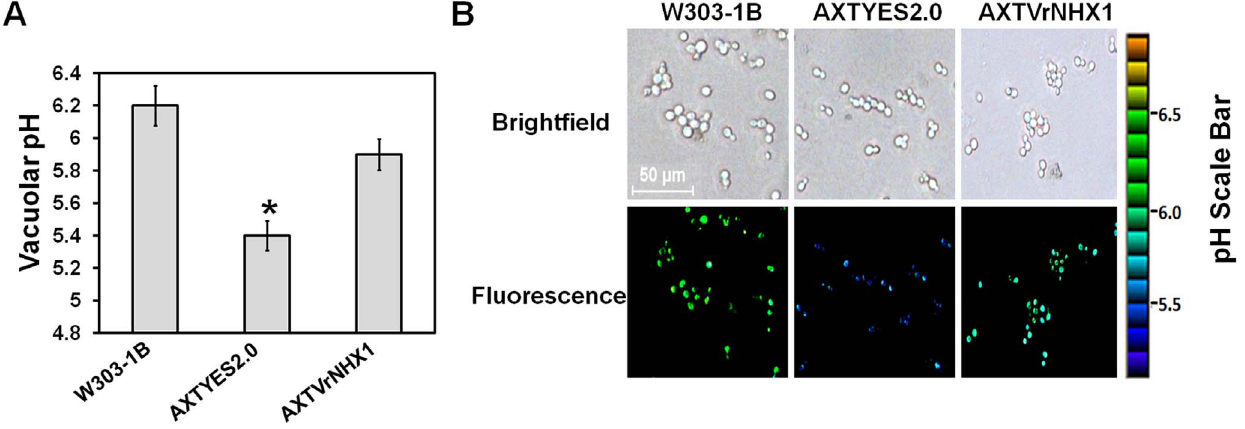
Figure 6. Measurement of vacuolar pH in yeast strains. (A) Vacuolar pH was measured for BCECF-AM loaded yeast strains W303-1B, AXTYES2.0 and AXTVrNHX1 as described in materials and methods following the calibration curve (Figure S4). Mean and SEs are plotted for three independent events (n=3) in each case. Statistically significant values at P # 0.05 are indicated as ‘‘*’’, using Bonferroni analysis. (B) Accumulation of pH-sensitive fluorescent BCECF dye in yeast vacuoles was measured. The yeast strains were grown in APGal media (pH 5.0), resuspended in minimal medium with BCECF-AM dye for 30 min at 30 u C. Yeast cells were visualized by Nikon eclipse Ti-U Fluorescence microscope (Nikon) at excitation wavelength of 440 nm. Bar scale: 50 m m.